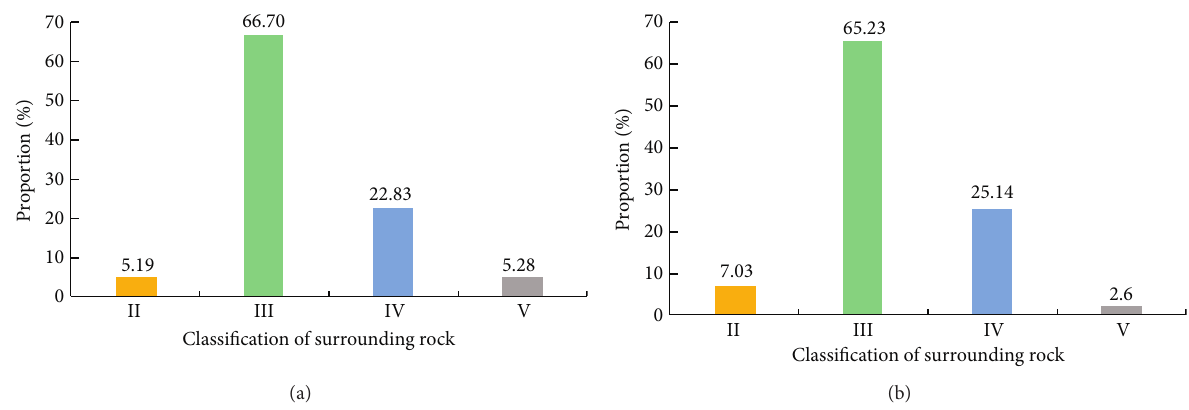
Figure 5: Engineering geological conditions. (a) Limestone classification statistics. (b) Granite classification statistics.